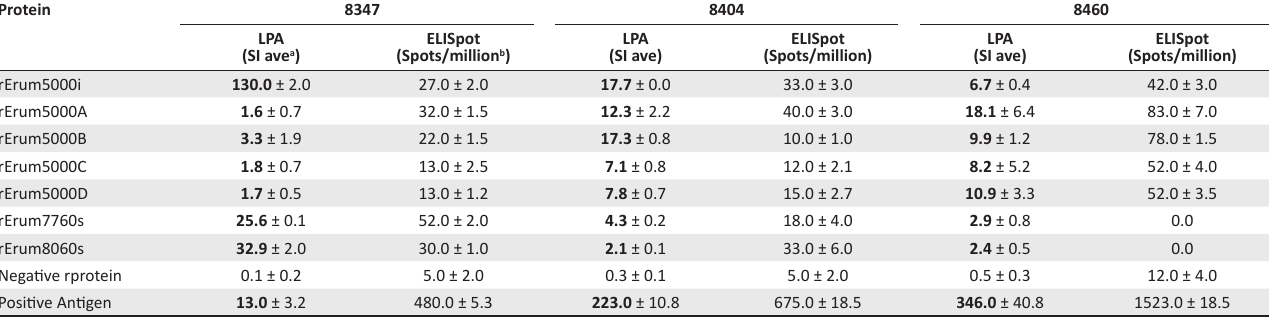
a , The stimulation index values of rErum proteins were compared to the negative value of negative rprotein. Only stimulation index values that were two times higher than the stimulation index of the negative rprotein and had significant p values ( p ≤ 0.05 as determined by Student’s t -test) were regarded as positive and these are indicated in bold; b , The number of spots per million cells of the rErum proteins were compared with the number of spots per million cells of the negative rprotein. Only the number of spots per million cells that were two times higher than the number of spots per million cells of the negative rprotein and had significant p values ( p ≤ 0.05 as determined by Student’s t -test) were regarded positive as underlined. LPA, lymphocyte proliferation assays; SI, stimulation